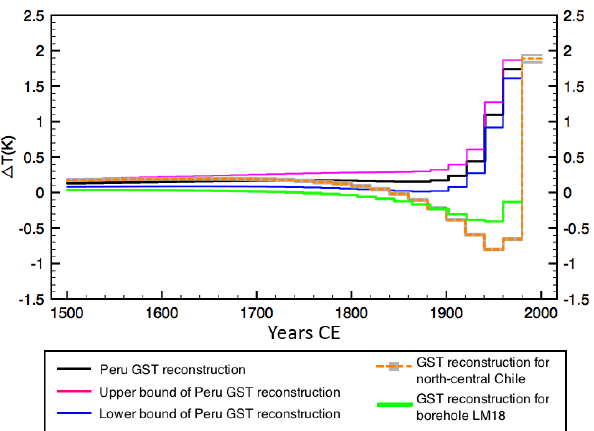
Figure 10. Comparison of GST histories for Peruvian boreholes (black), Peruvian profile LM18 (in green), and north-central Chile (orange) with its upper and lower bounds (grey shaded area). The GST for the Peruvian boreholes was obtained by the simultaneous inversion of LM18 and LOB525 and is relative to the measurement time (1979). Inversion of LM18 shows a cooling similar to that ob- served in north-central Chile. The inversions of the upper and lower bounds of the temperature anomaly for the Peruvian boreholes are represented by the pink and blue lines, respectively.